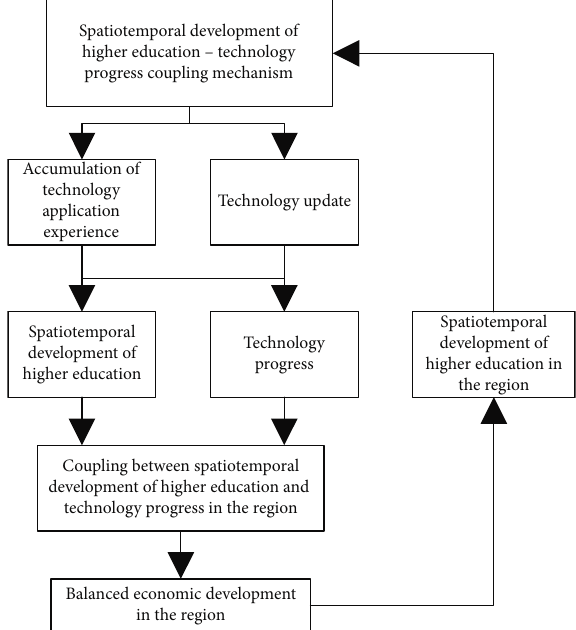
Figure 4: Principle of how technology progress coupling mech- anism affects regional economic growth.